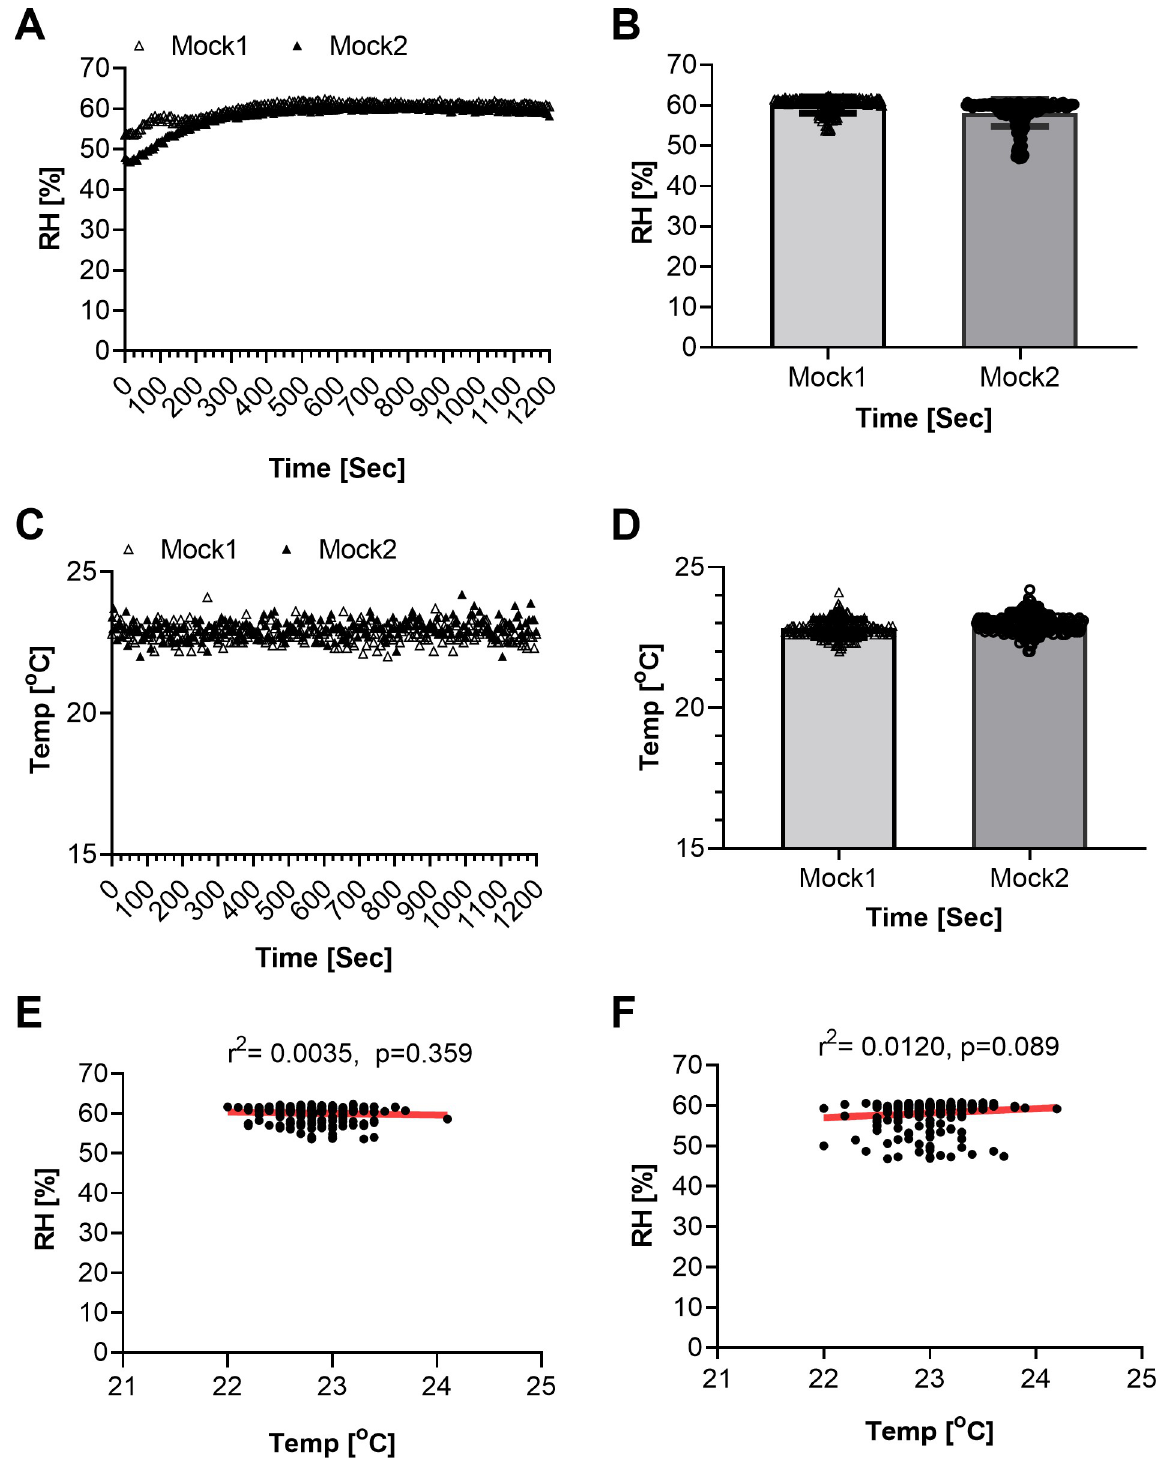
Fig 2. Environmental factors measured in chamber during mock aerosol experiment. Environmental factors measured for mock1 and mock2 during aerosol procedures by AeroMP system; range of relative humidity plotted with respect to time (0–1200 sec) (A), mean relative humidity (RH) mock1 (60.05%), mock2 (58.12%) plotted versus time (0–1200 sec) (B), temperature recorded for mock1 and mock 2 every 5 sec up to 1200 sec (20 min) and plotted with respect to time (C), mean temperature recorded for mock1 (22.8˚C), mock2 (22.9˚C) plotted versus time up to 20 min (0–1200 sec) (D), range of relative humidity plotted versus temperature for mock1 and their linear regression (r 2 = 0.0035, P = 0.359) (E), relative humidity plotted versus temperature measured for mock2 and their linear regression (r 2 = 0.012, P = 0.089) (F). https://doi.org/10.1371/journal.pone.0276130.g002 PLOS ONE | https://doi.org/10.1371/journal.pone.0276130 October 13,